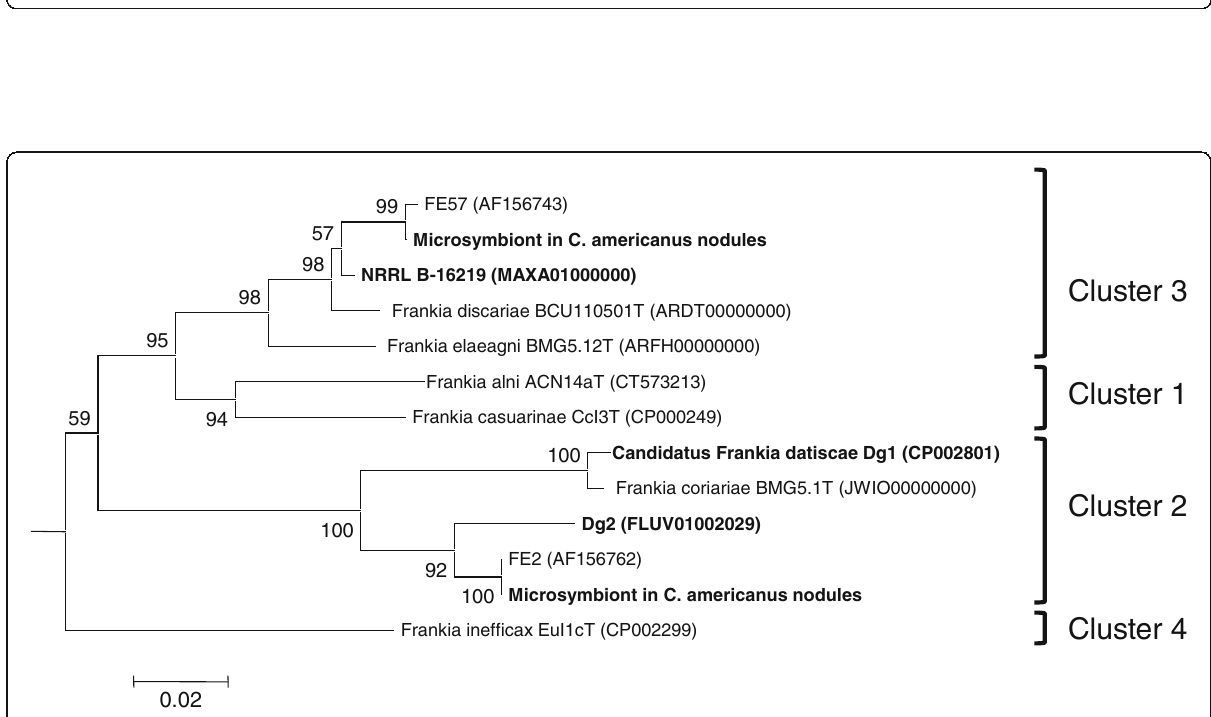
Fig. 4 Maximum likelihood phylogeny based on amino acids of nod A ( a ), nod B ( b ), nod C ( c ) and nod H ( d ). GC-content is provided for nod genes and for genomes (in parenthesis). Bootstrap and probability values larger than 50% are only